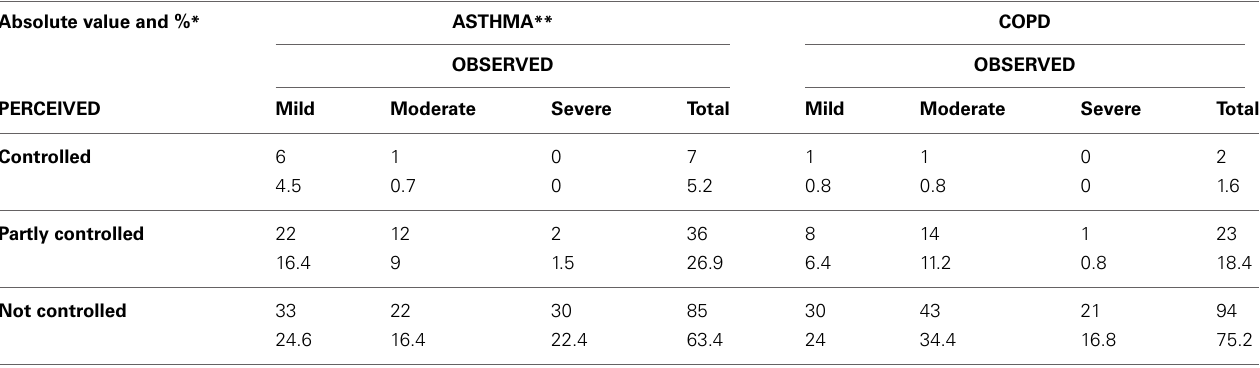
Table 2 | The perceived and observed condition in asthma and